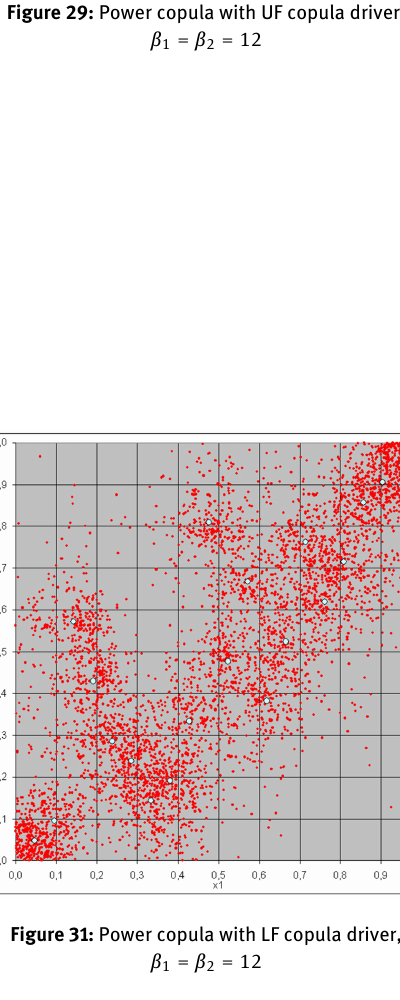
Figure 28: Power copula with UF copula driver, Figure 29: Power copula with UF copula driver,